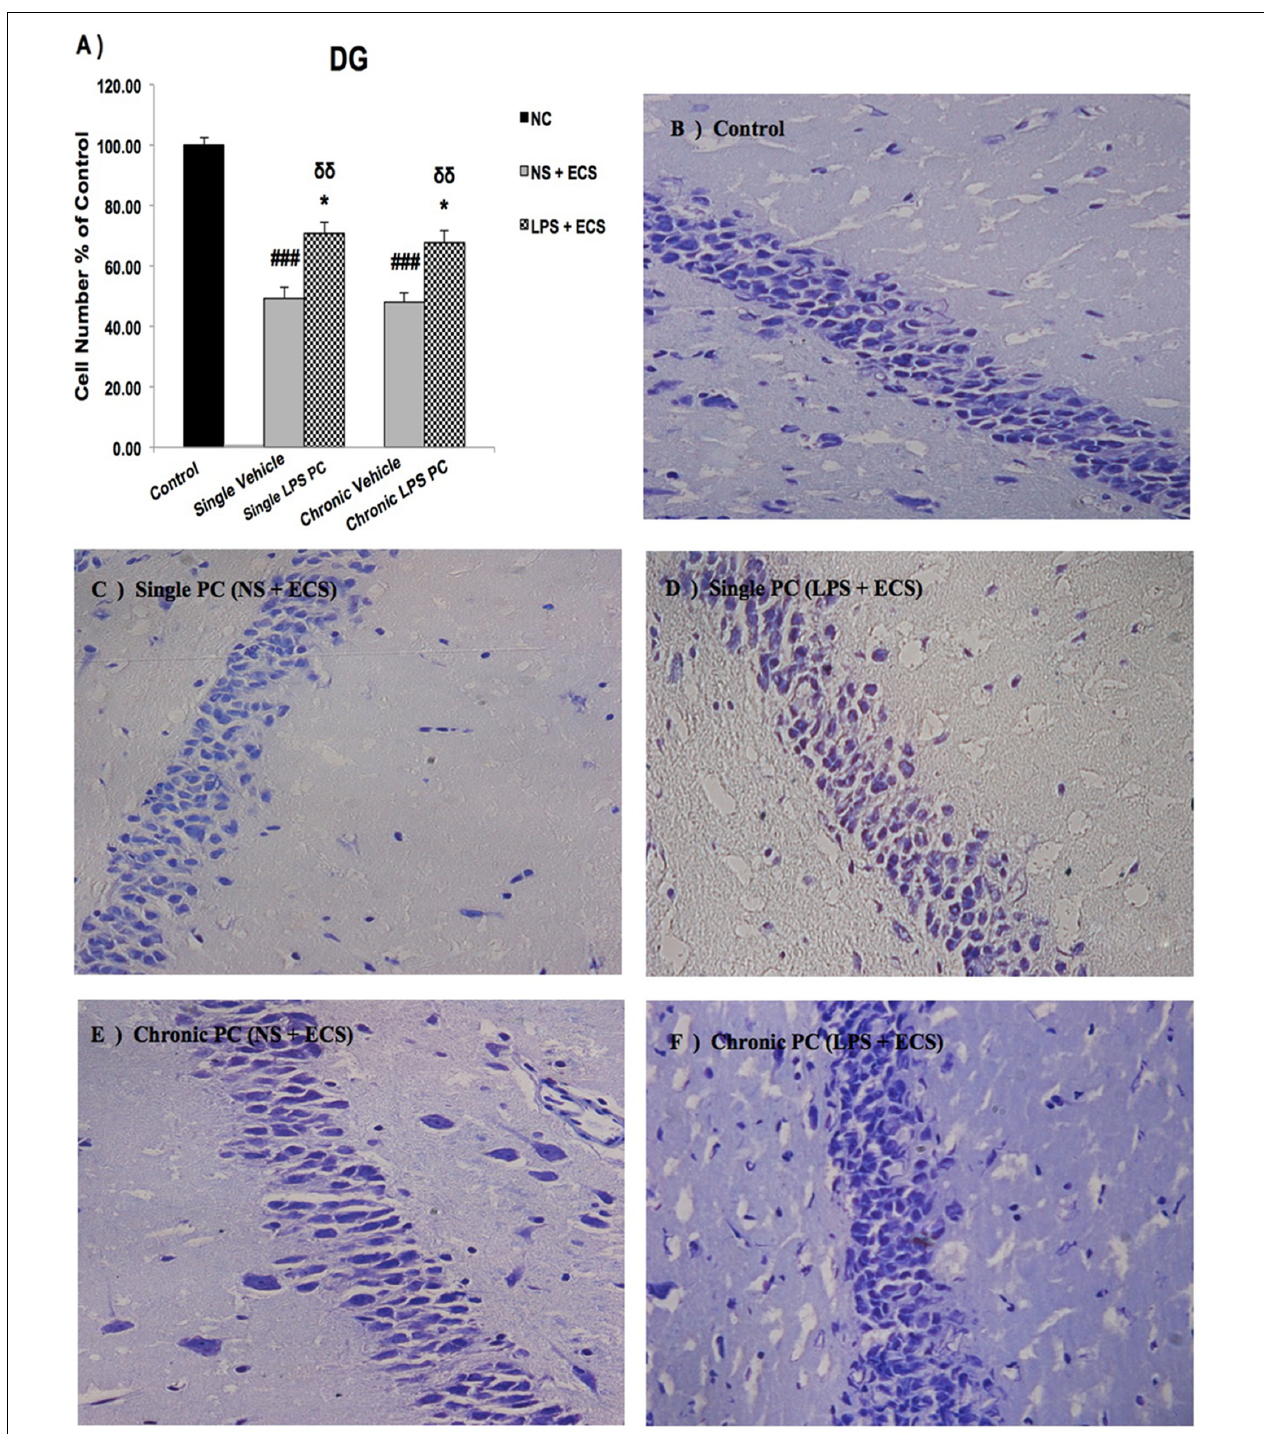
FIGURE 5 | Photomicrographs of Nissl-stained DG sub-region of rat brain hippocampus in the ECS model of epilepsy ( n = 3). (A) Effect of single low dose and chronic ultra-low dose of LPS preconditioning on the number of DG cells, (B) control, (C) vehicle (single NS), (D) single LPS preconditioned groups, (E) vehicle (chronic NS), and (F) chronic LPS preconditioned groups in the ECS model. Scale bars are equal to 50 µ m. Asterisk ( ∗ ) denotes a significant difference between the preconditioned groups and vehicle groups. Delta ( δ ) denotes a significant difference between the preconditioned groups and control groups. Hash (#) denotes a significant difference between the vehicle groups and control groups. Statistical analysis has been done according to the one-way ANOVA with significance levels of ∗ ρ < 0.05; δδ ρ < 0.01; and ### ρ < 0.001. Data are shown as mean% ± SEM of three animals ( n = 3), which expressed as the cell number percentage with respect to the control. ECS, electroconvulsive shock; NS, normal saline; LPS, lipopolysaccharide; PC, preconditioning; NC, no current was passed through the electrodes.